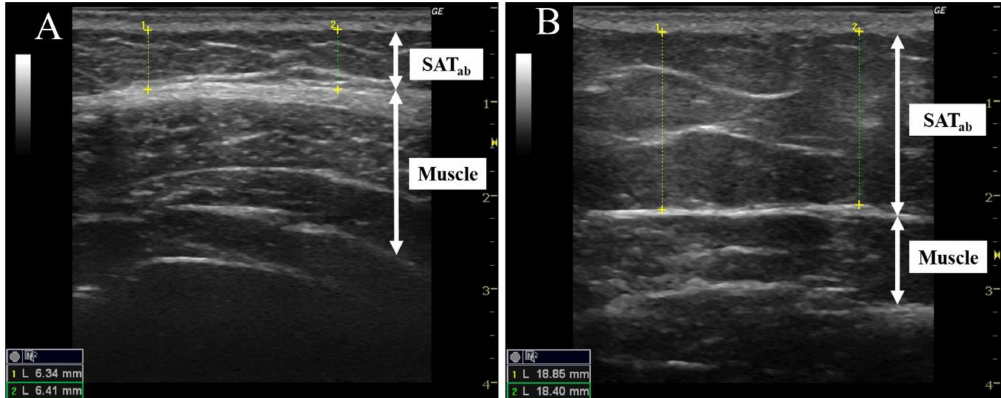
Figure 1. Typical ultrasonic images of the subcutaneous adipose tissue in the abdominal region (SAT ab